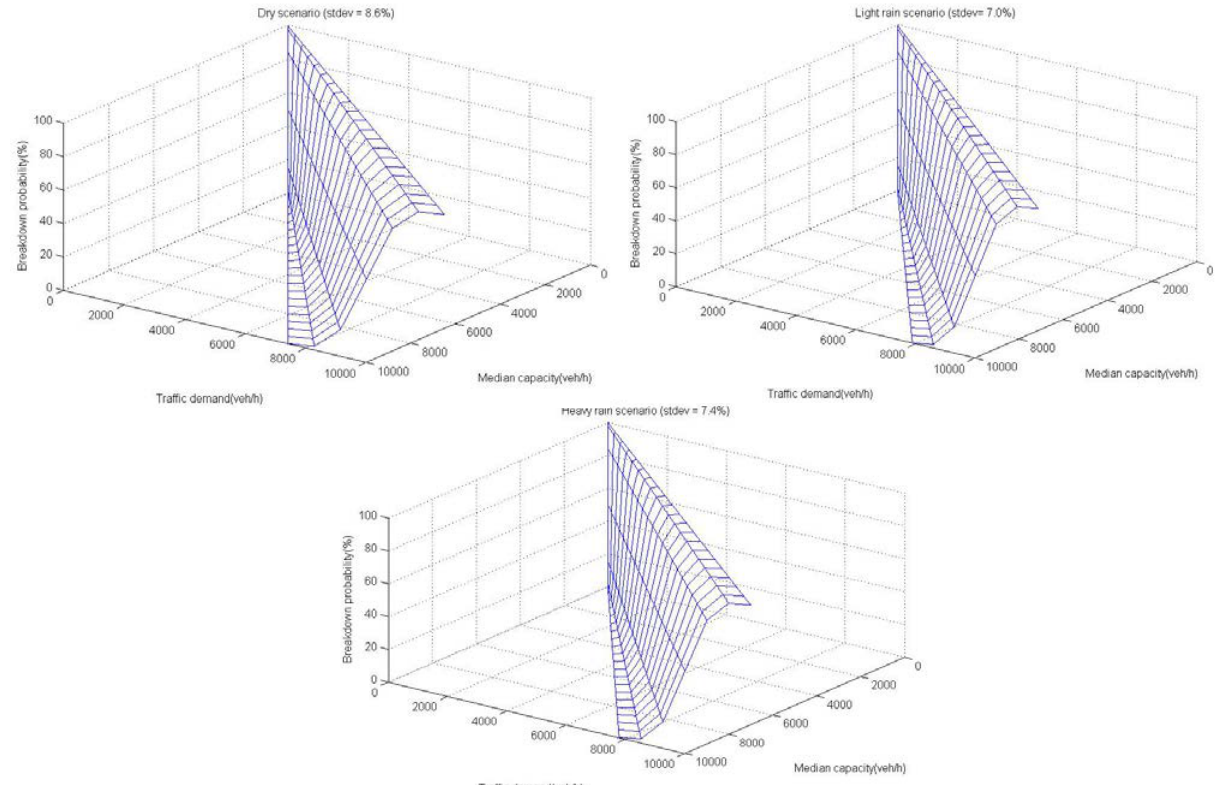
Figure 2. 3D-plot breakdown probability dry (a), light rain (b) & heavy rain (c)